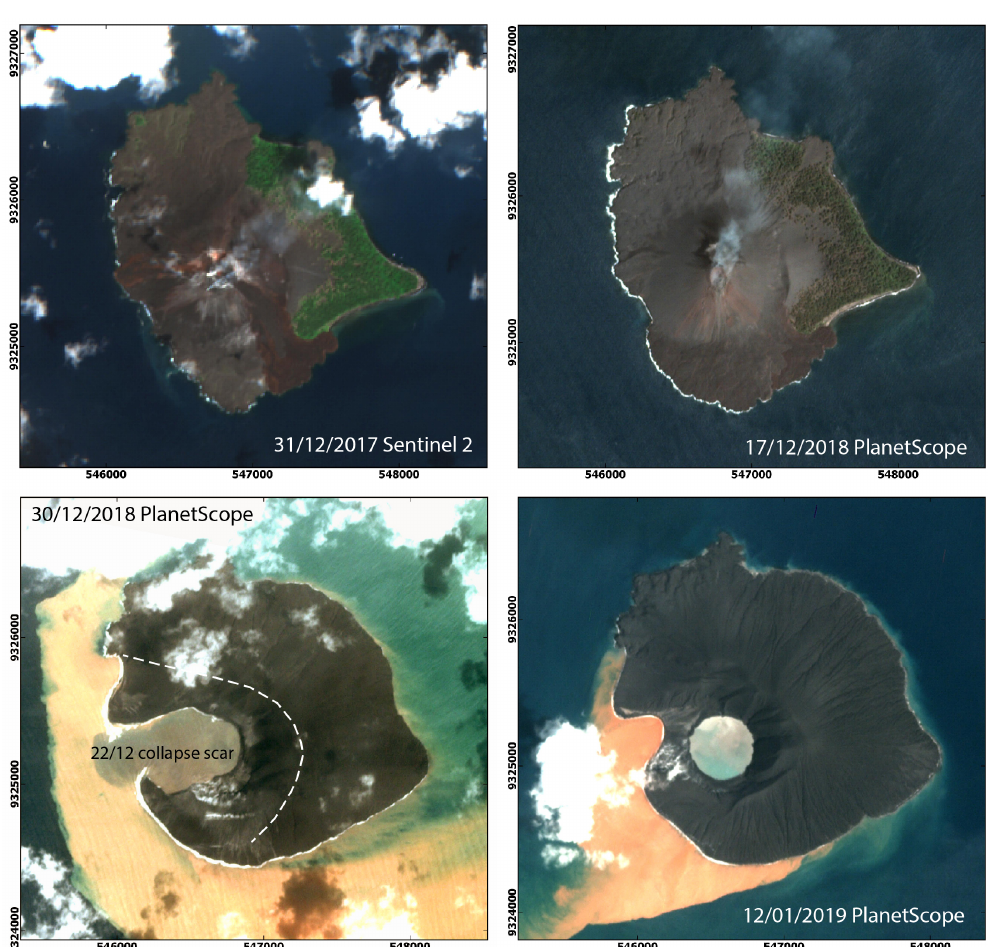
Figure A1: Evolution of the island of Anak Krakatau from December 2017 to January 2019, as seen from satellite imagery (Sentinel-2 and PlanetScope).